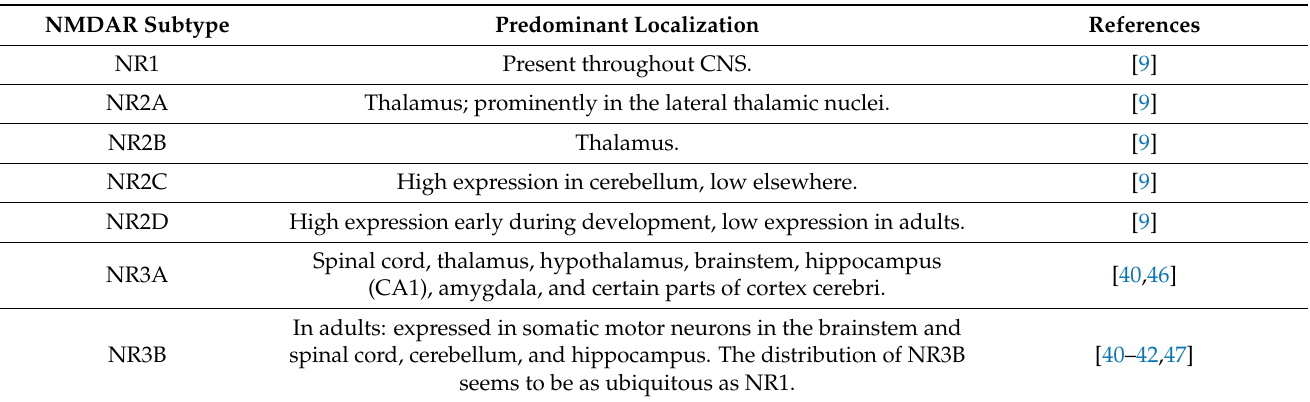
Figure 2. Potential binding sites for ligands that modulate the activity of N-Methyl-D-Aspartate Receptor (NMDAR). The NMDAR is assembled as tetramers; two NR1 and two NR2 subunits forming a dimer–dimer structure or two NR1 subunits associating with one NR2 and NR3 subunit. The channel construction with different domains gives rise to ligand binding or allosteric modulatory sites that either work as an NMDAR agonist or antagonist. Table 1. Predominant localization of the NMDAR subunits.